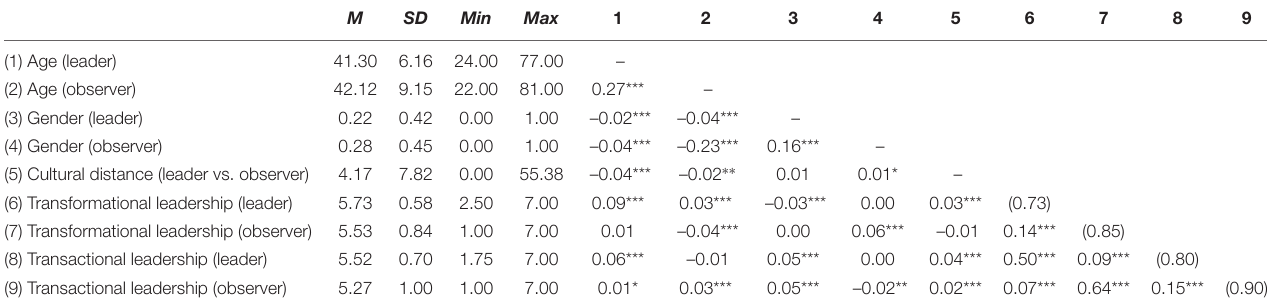
TABLE 2 | Descriptive statistics and intercorrelations for leader–observer dyads.